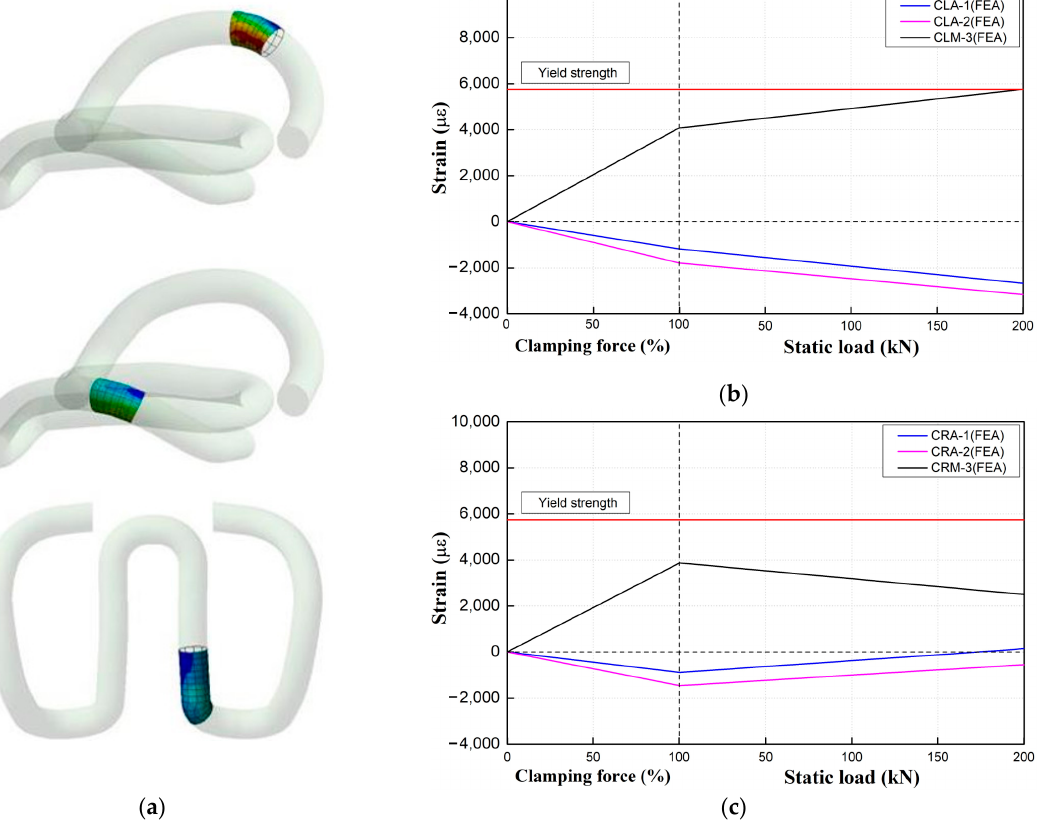
Figure 13. Numerical analysis results for tension clamps. ( a ) Stress-concentrated part. ( b ) Left strain. ( c ) Right strain.